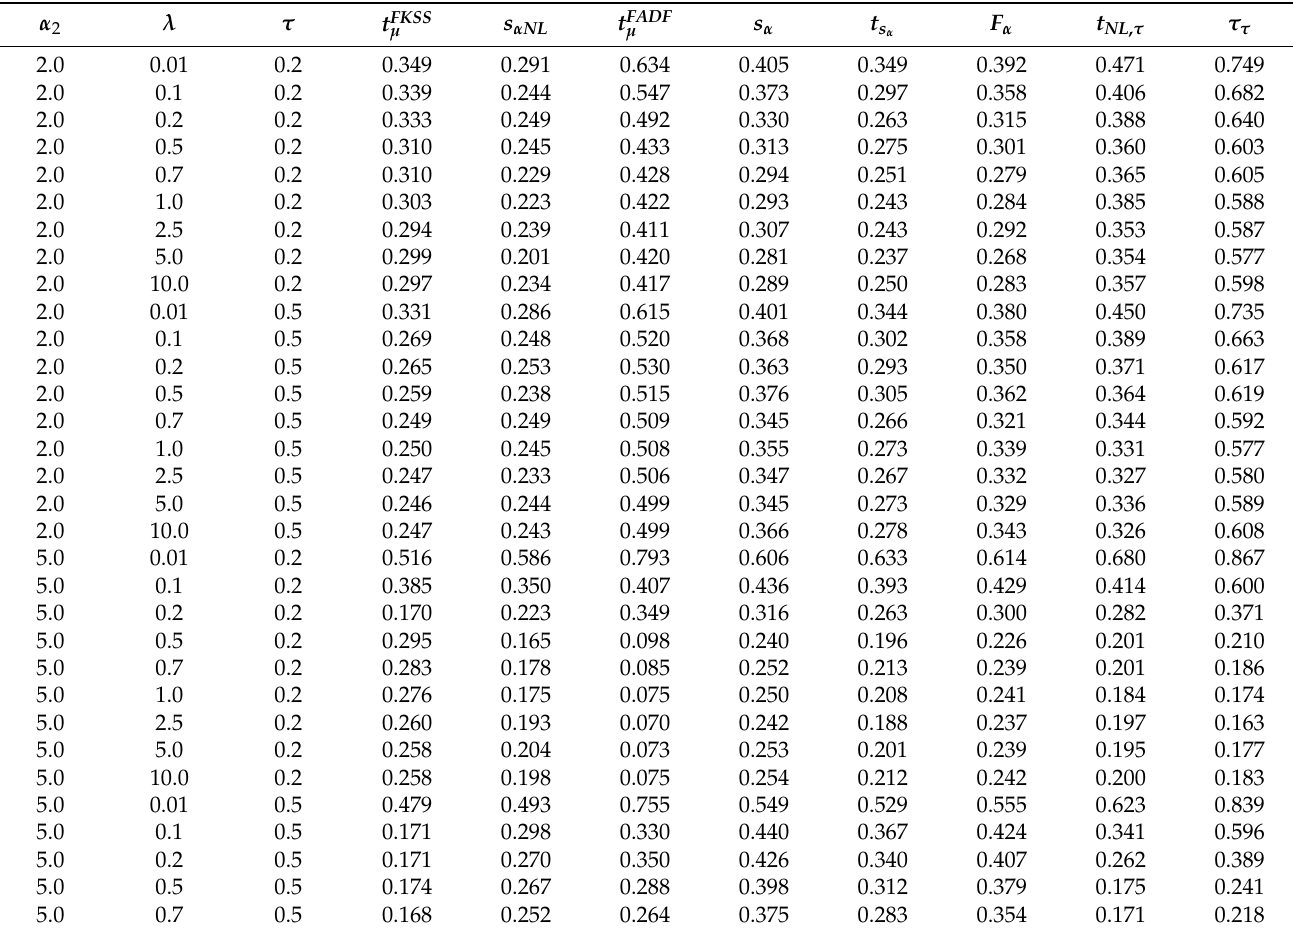
Table 5. The simulated powers of alternative tests under the Leybourne, Newbold and Vougas